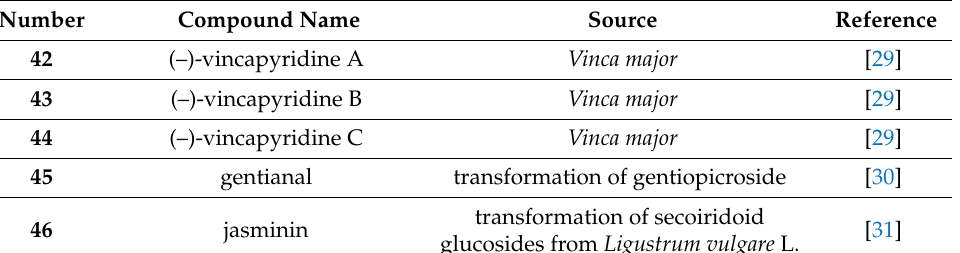
Table 3. Pyridine alkaloids derived from hemiacetal secoiridoids (Type III).